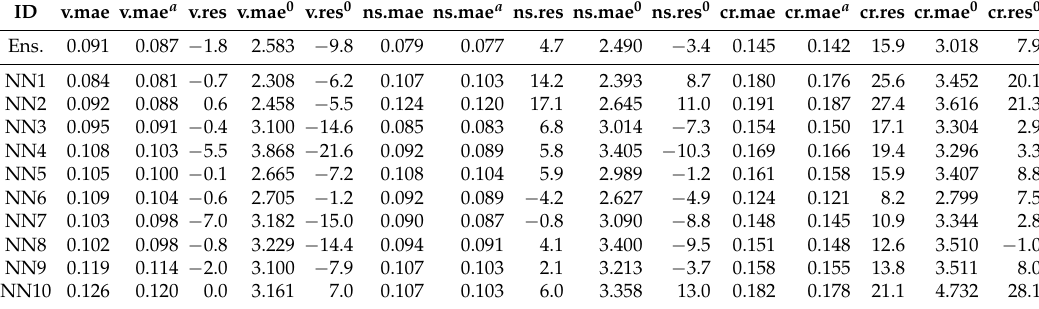
Table 4. Validation figures for the ensemble and the 10 best performing neural networks. MAEs in %.